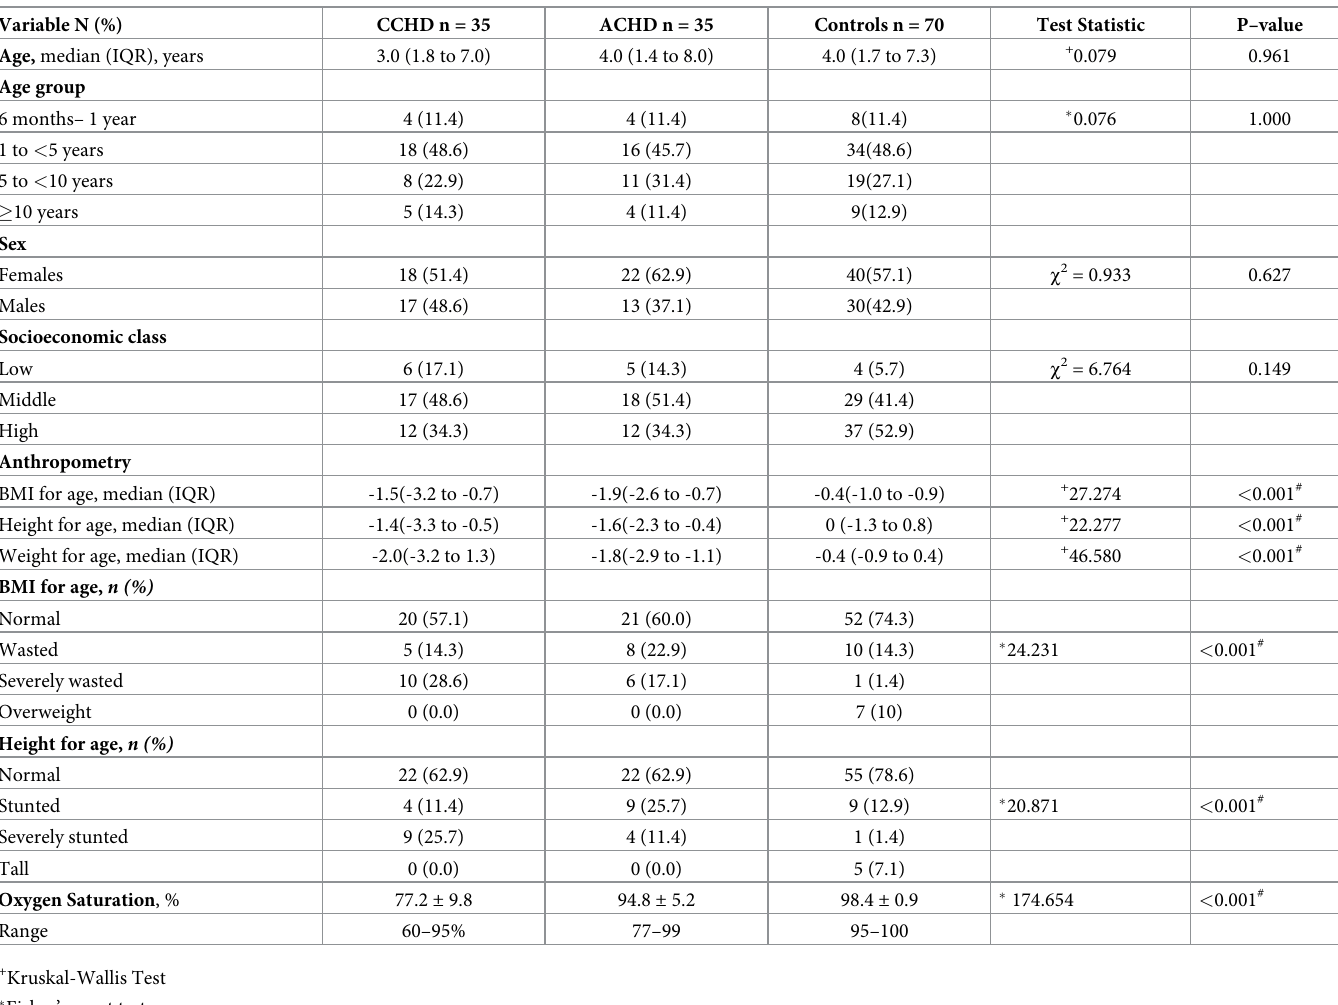
Table 1. Socio-demographic and anthropometry of study